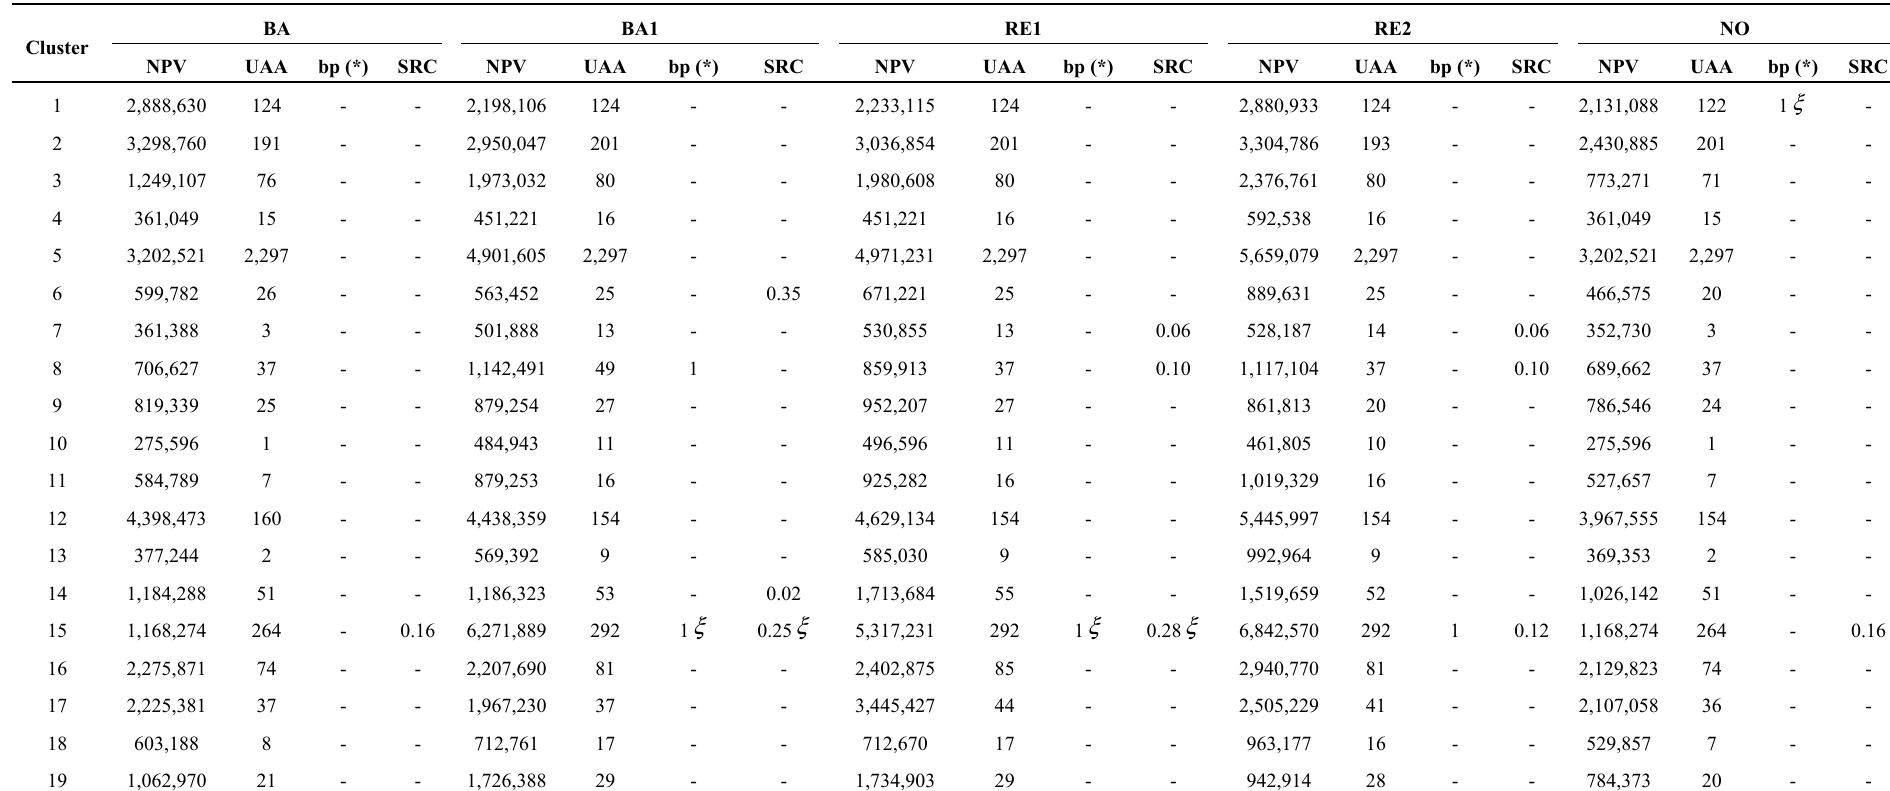
Table 4. Baseline (data per